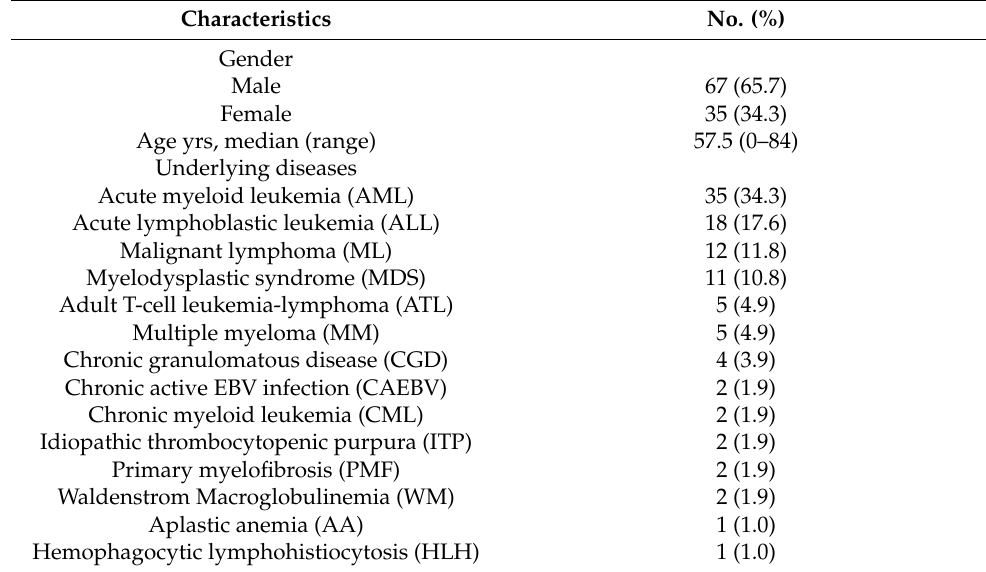
Table 1. Characteristics of 102 IFD cases.